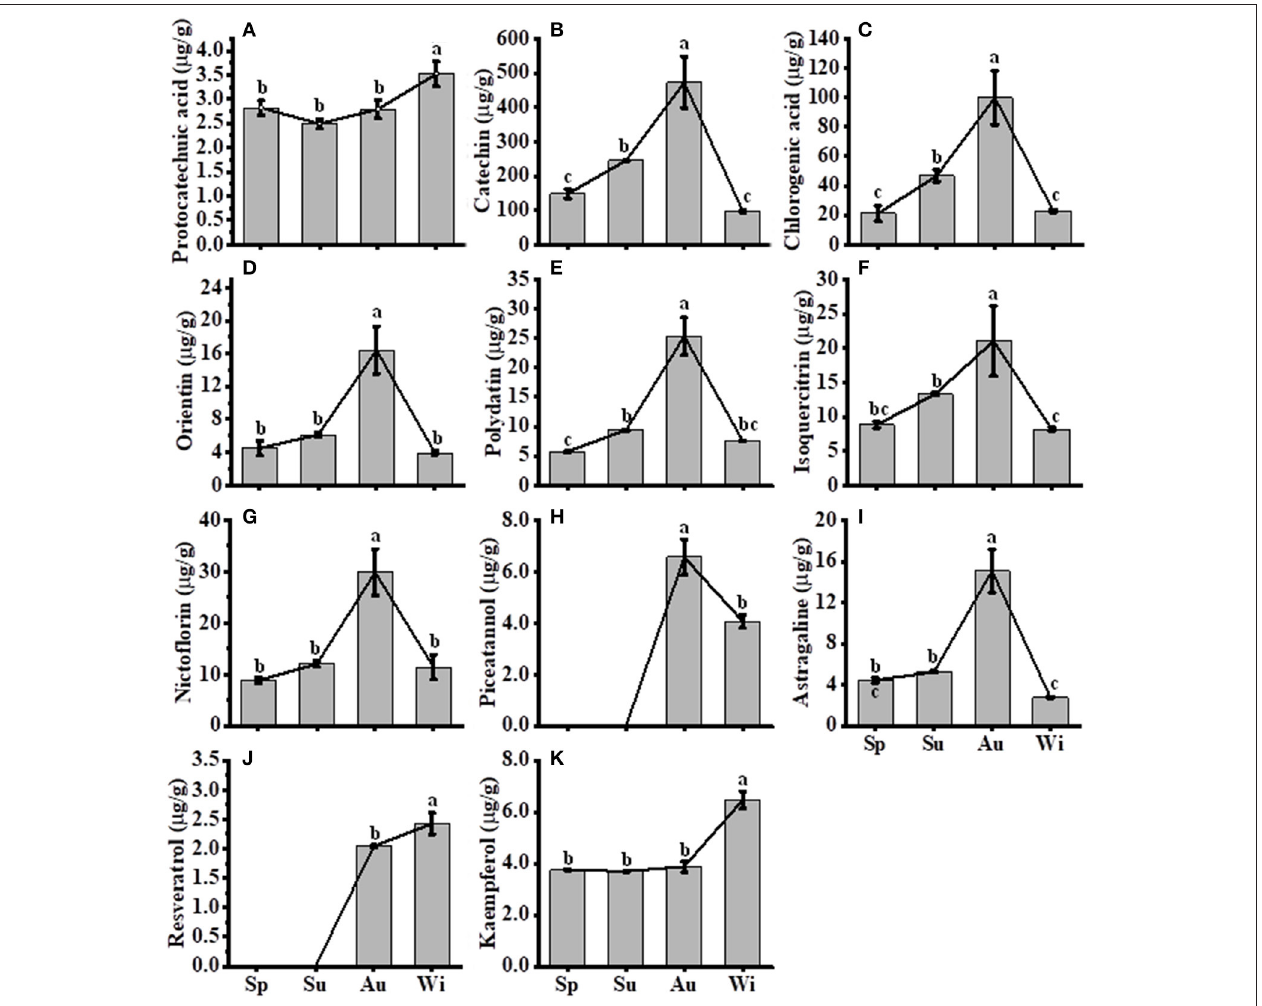
FIGURE 7 | Contents of compounds in T. hemsleyanum FD-TRs. Sp, Spring; Su, Summer; Au, Autumn; Wi, Winter. (A) protocatechuic acid, (B) catechin, (C) chlorogenic acid, (D) orientin, (E) polydatin, (F) isoquercitrin, (G) nictoflorin, (H) piceatannol; (I) astragaline; (J) resveratrol, and (K) kaempferol. Bars represent means + SE ( n = 5). Bars bearing the same letter are not significantly